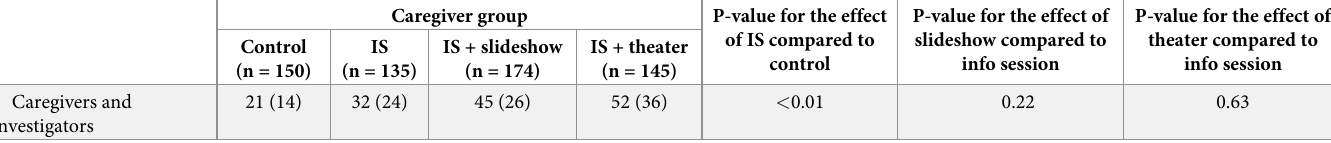
analyzed separately.